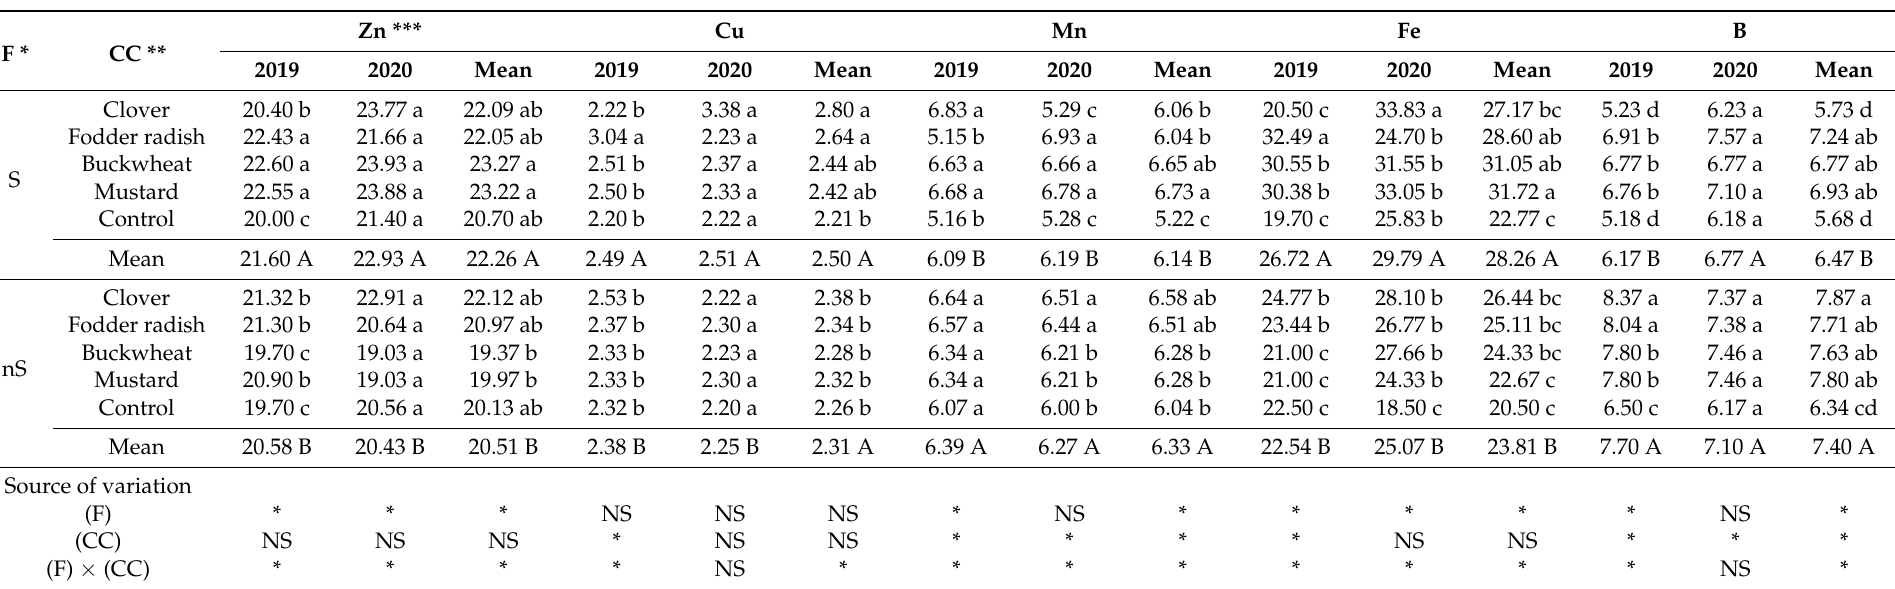
Table 4. Micronutrient analysis of winter garlic bulb cultivated under sulfur and catch crops in